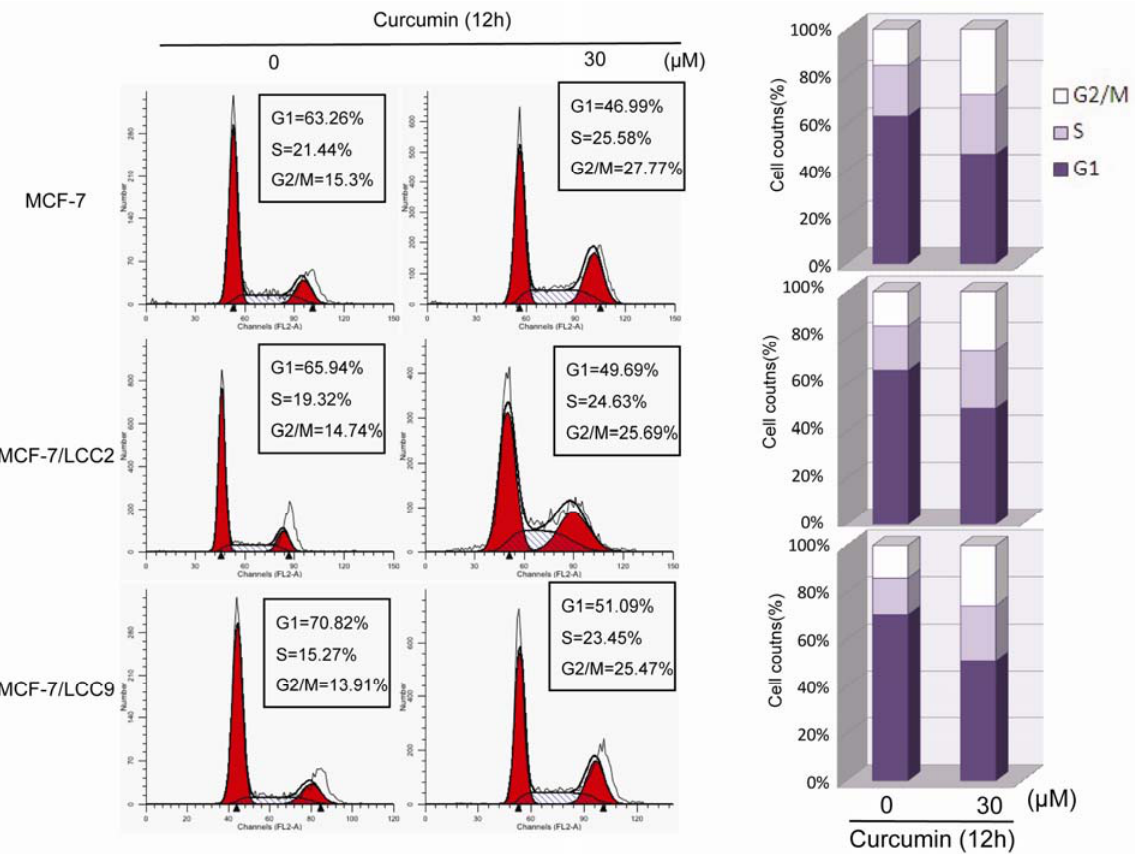
Figure 3. Curcumin induces G2/M phase arrest in MCF-7/LCC2 and MCF-7/LCC9. Cells were treated with 30 μ M for 12 h and DNA content was analyzed by flow cytometry. The percentage of cells in G1, S and G2/M of cell cycle are shown. These results were from one representative experiment of three independent